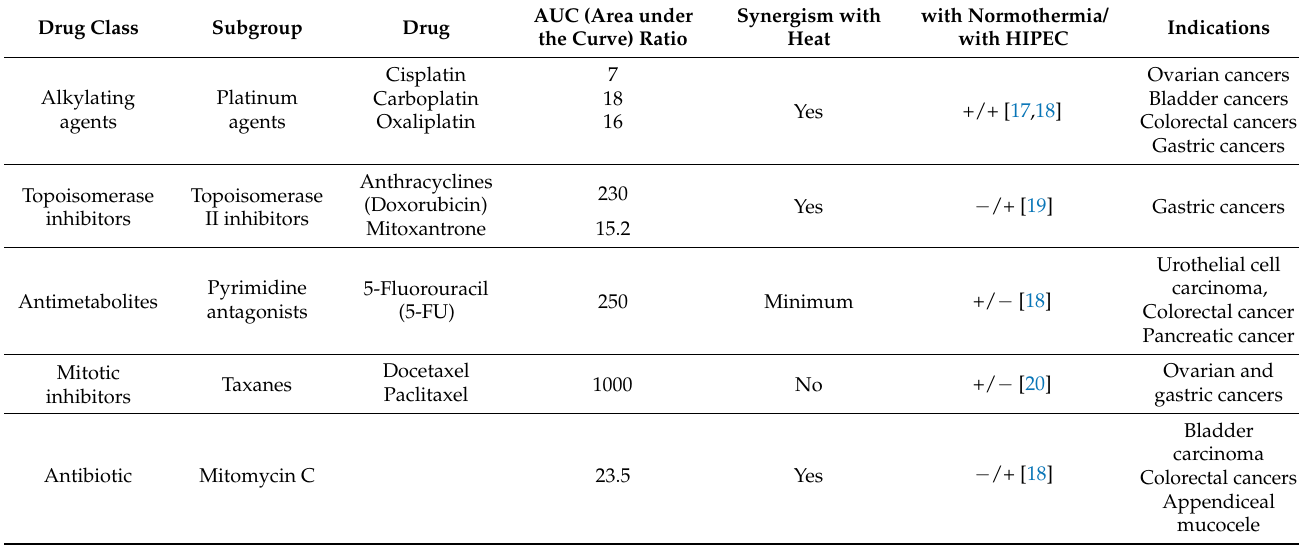
Table 1. Most commonly chemotherapeutic agents used during intraoperative chemoperfusion (IPC) for peritoneal carcinomatosis (PC). HIPEC: hyperthermic intraperitoneal